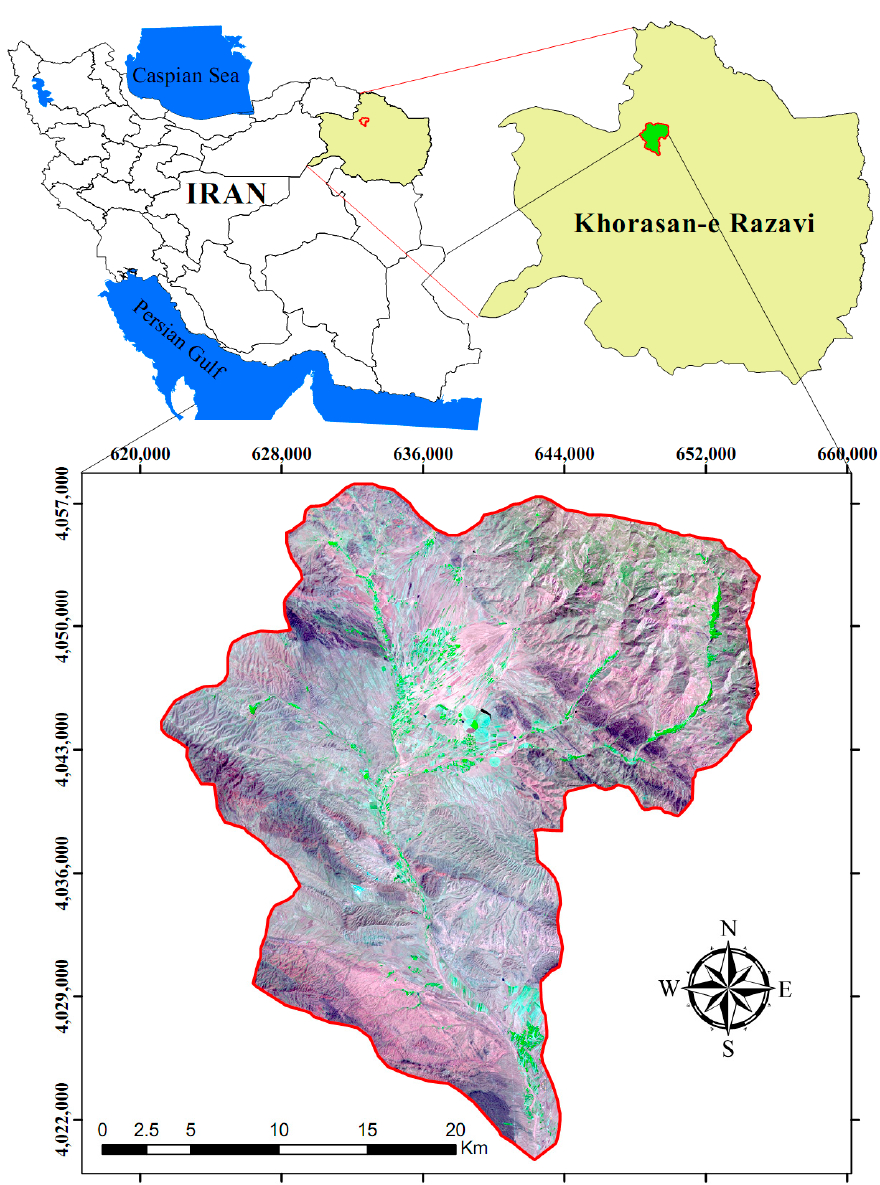
Figure 2. Location of the Hesare-No Basin in Khorasan-e Razavi Province, Iran.